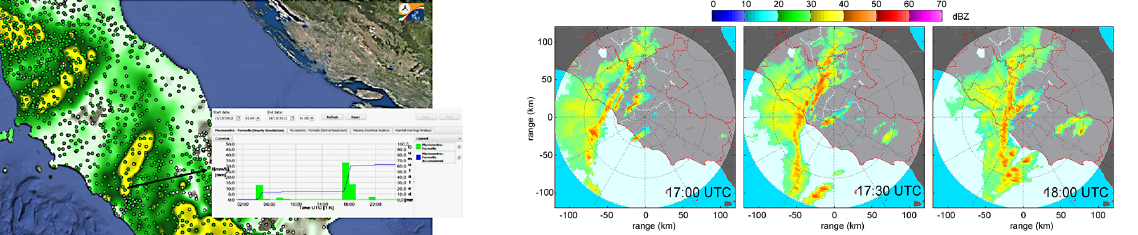
Figure 9. Daily accumulated rainfall recorded by rain gauges (green dots on the map) on 15 October 2012; the inset shows the hourly ac- cumulated precipitation for the station of Formello (north of Rome) – courtesy of the DPC (DEWETRA system).